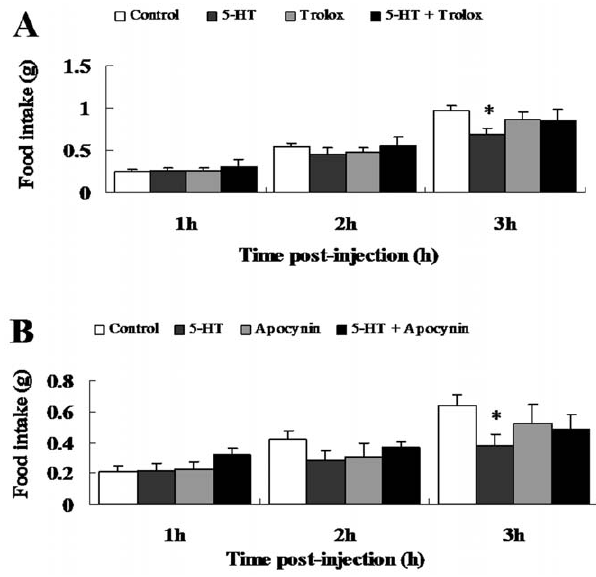
Figure 1. Effects of 5-HT, Trolox and Apocynin on food intake after third ventricle injection. Food intake was measured manually by weighing of pre-weighed food pellets at 1, 2 and 3 h post-injection. (A) ICV co-injection with 5-HT and Trolox. n=11–12 per group. (B) ICV co-injection with 5-HT and Apocynin. n=8–9 per group. Data are expressed as the means 6 SEM. *, 0.01 , p , 0.05, vs. the